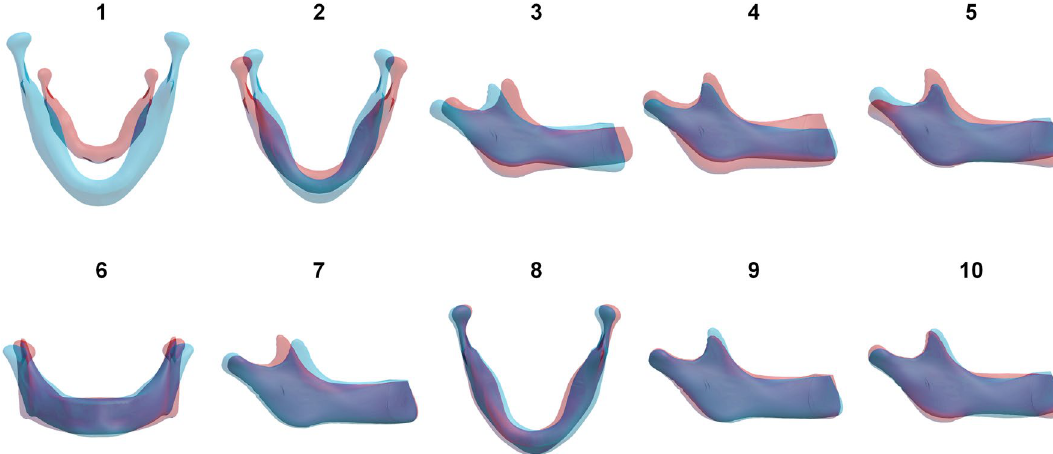
Figure 4. Principal component modes 1–10. For each mode, two models are shown: a weight of − 3 standard deviations (red) and a weight of + 3 standard deviations (light blue). Dark blue zones represent overlap between these models.